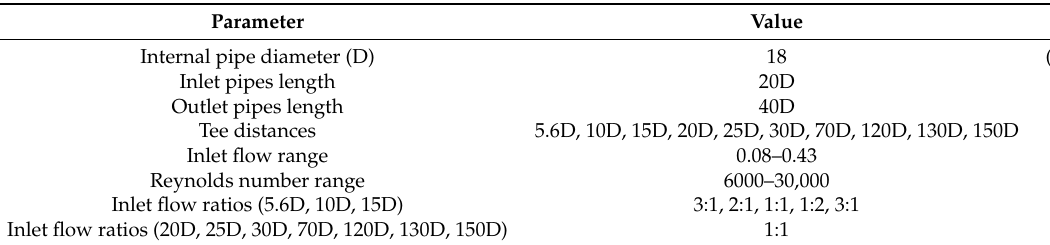
Table 1. Experimental setup data overview for S and U configuration.